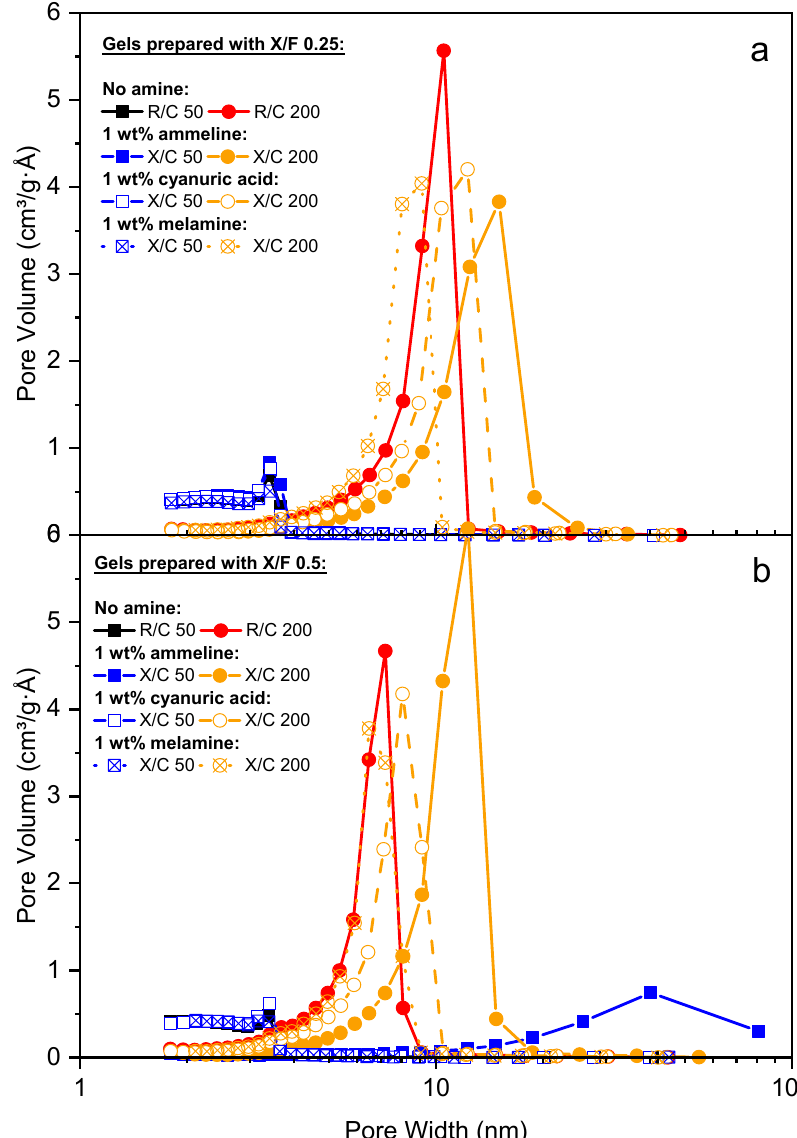
Figure 2. Pore size distributions for gels prepared with 1 wt% of additives with ( a ) X/F 0.25 and ( b ) X/F 0.5.